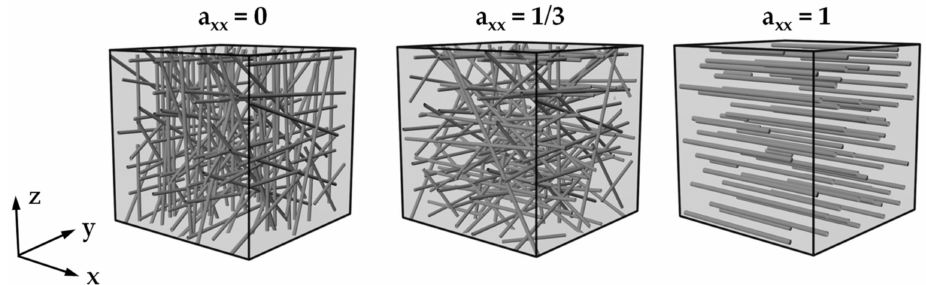
Figure 1. Evaluation of the fiber orientation distribution with tensor components using the example of the tensor a xx with fibers oriented perpendicular to the corresponding axis (a xx = 0), a three- dimensional random distribution (a xx = 1/3), and fibers oriented in the direction of the corresponding axis (a xx =